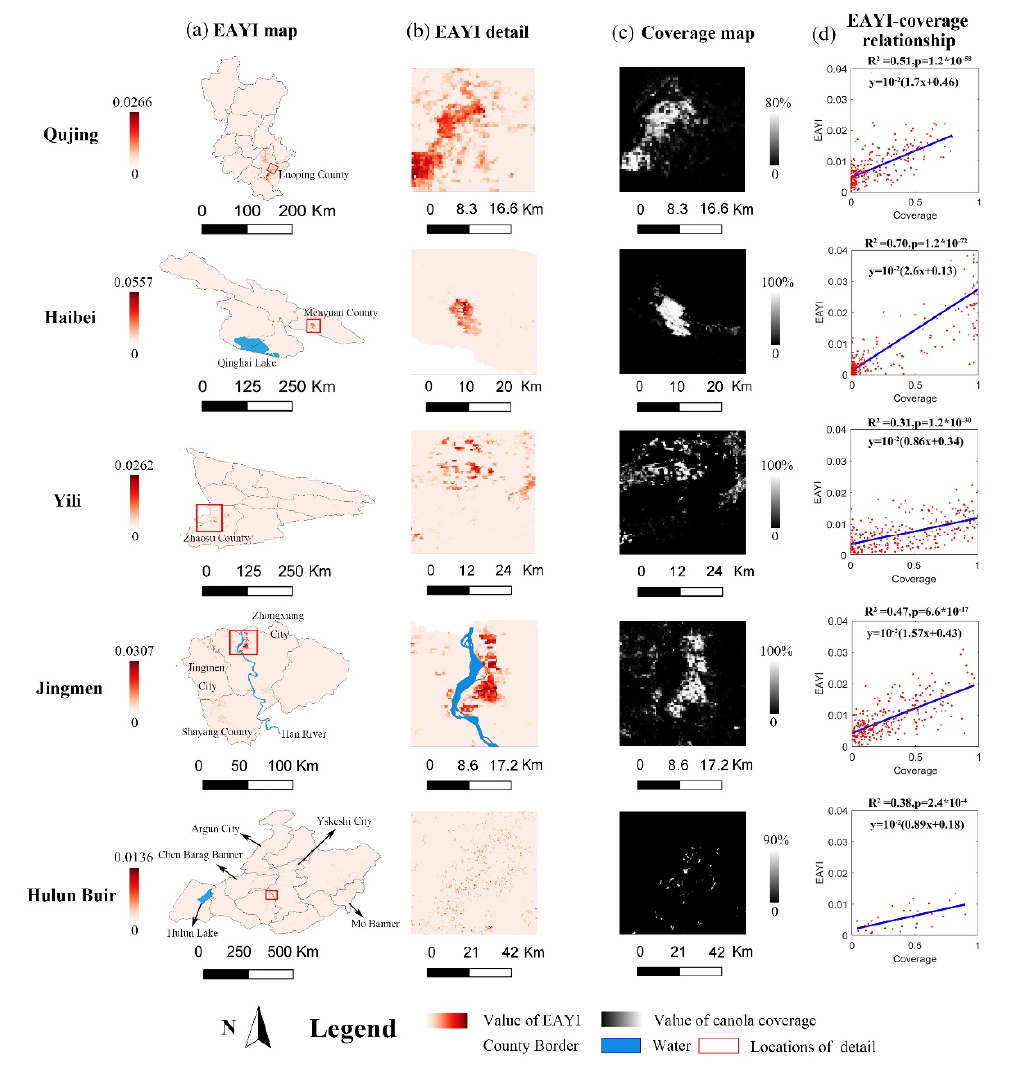
Figure 8. ( a ) EAYI maps in five subareas; ( b ) EAYI details in five subareas; ( c ) Reference canola coverage maps in five subareas; ( d ) Scatterplots between EAYI and reference canola coverage of validation samples in five subareas.